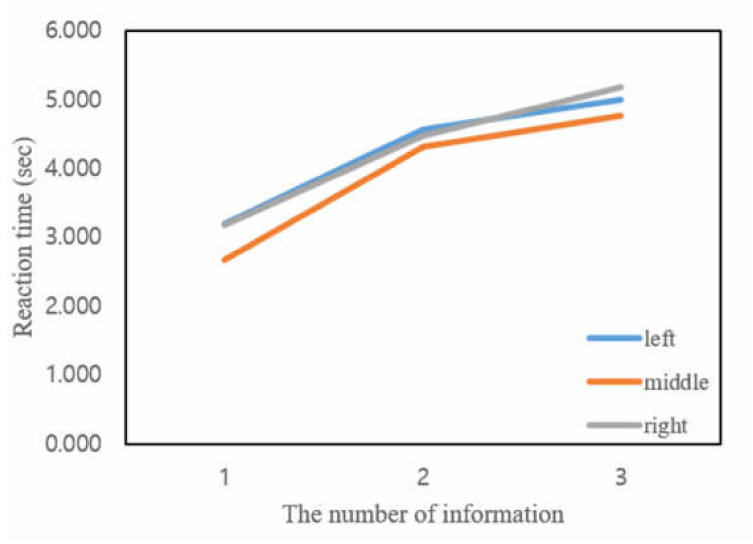
Figure 7. Reaction time according to the level of the number of information and area of